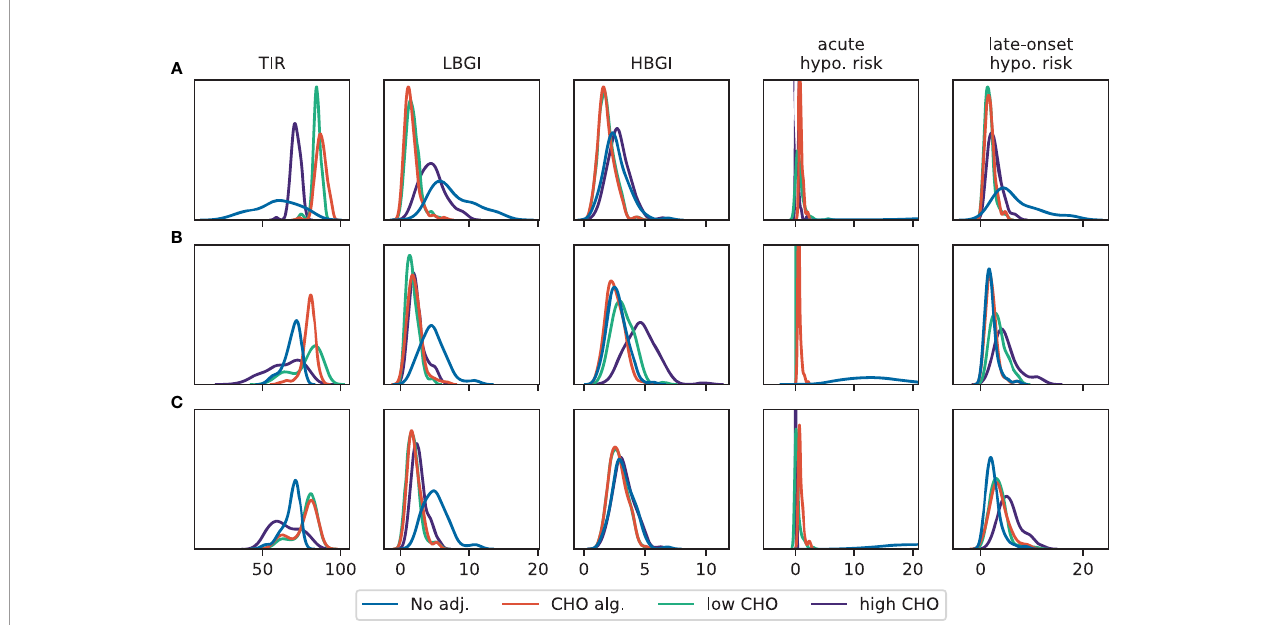
FIGURE 5 | Distribution of TIR, LBGI and HBGI and the corresponding acute and late-onset hypoglycemia risk for different adjustments from 24h-simulations of a patient population. Exercise is performed for 90 min with HR = 140bpm. (A) Scenario 1: exercise in postabsorptive state. (B) Scenario 2: exercise with prior insulin bolus reduction. (C) Scenario 3: exercise without prior insulin bolus